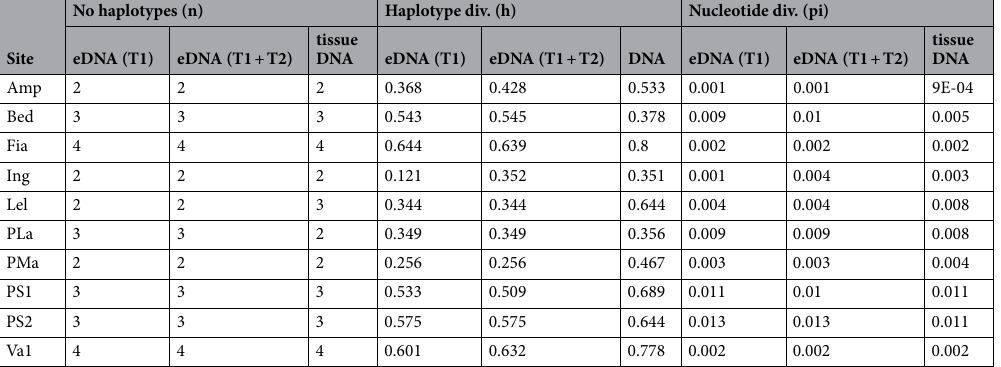
Table 3. Genetic diversity estimates for Rana temporaria populations in the Province of Trento: results of eDNA metabarcoding from the present study compared to the reference dataset 41 . eDNA (T1): eDNA